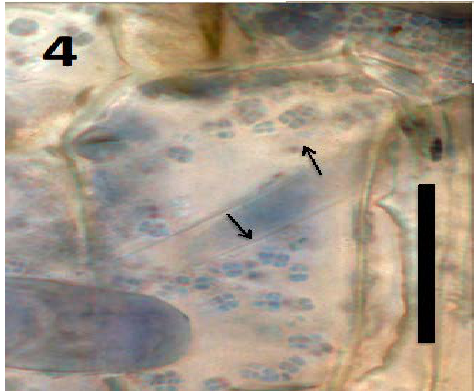
Figure 4. Parenchyma cell of tomato seedling inoculated with Micrococcus luteus showing tetrads of the bacterium (arrows) in periplasmic space of parenchyma cell (bar = 20 µm; stained with 3,3-diaminobenzidine followed by aniline blue).